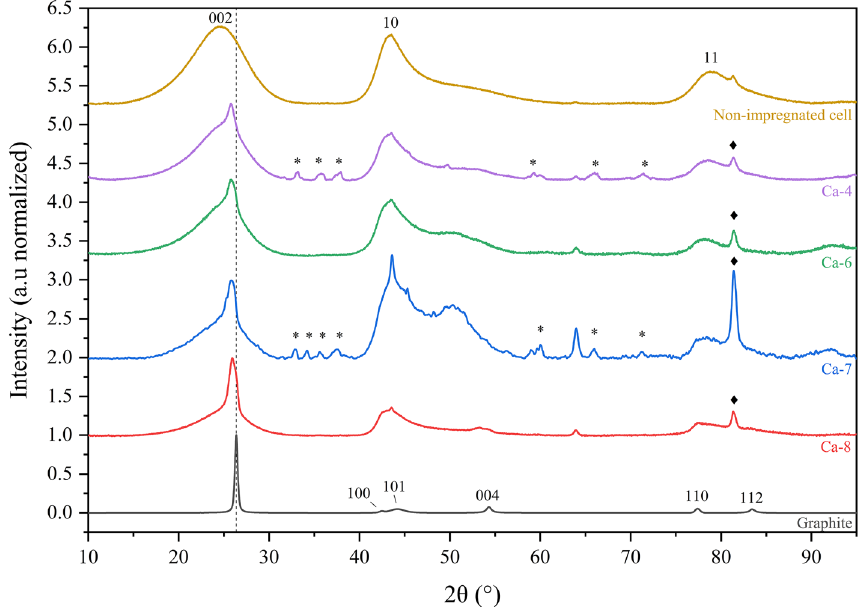
Figure 1. XRD patterns (λ = 1.542 Å) of non-impregnated, Ca-4, Ca-6, Ca-7, Ca-8 samples and commercial graphite. The peak label (asterisk) belongs to the Ca species. The peak label (closed diamond) belongs to the sample